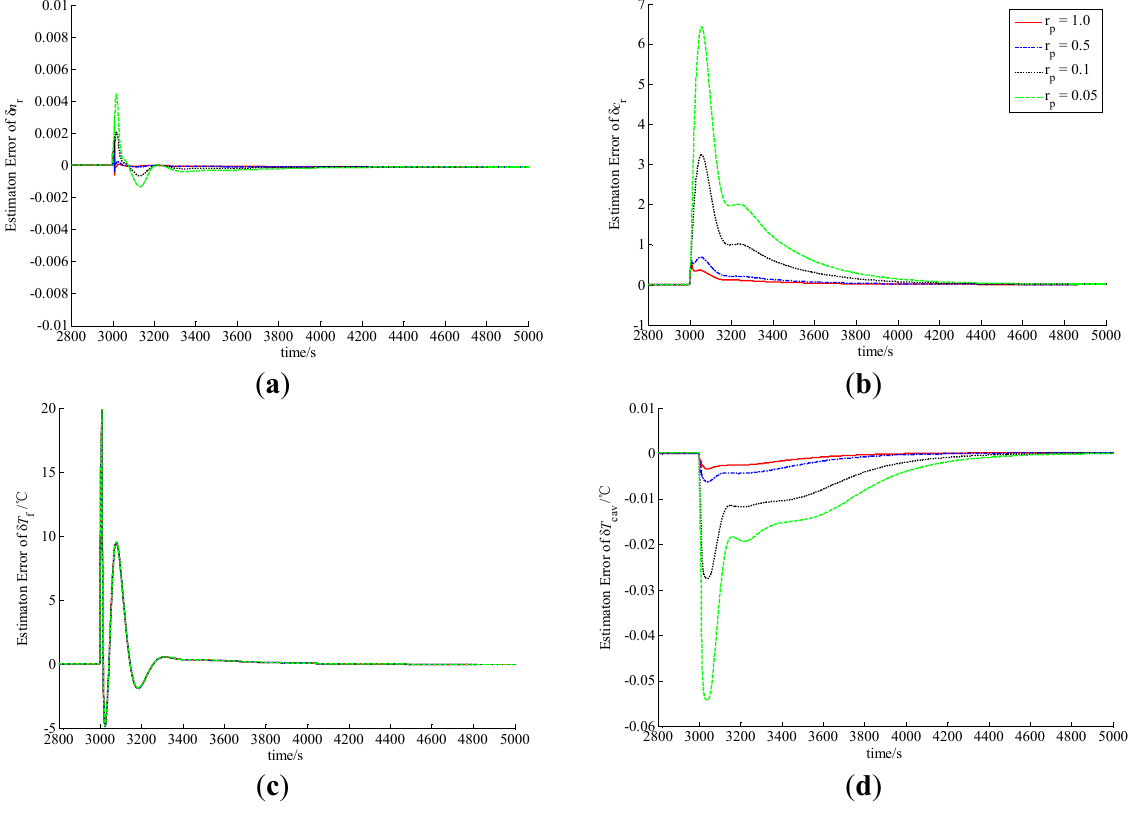
; ( b ) δ c ; ( c ) δ T and ( d ) δ T r r f